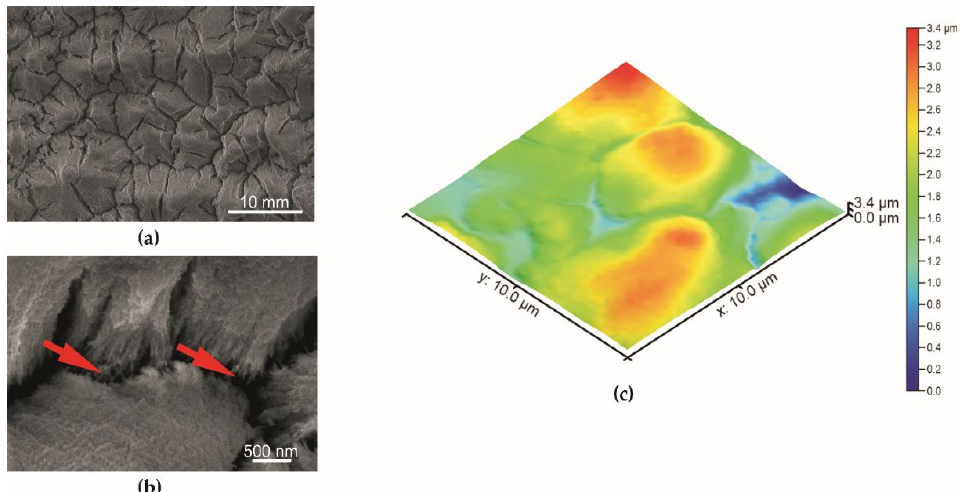
Figure 5. The surface of the specimen from Series 2 before impregnation by PDMS: ( a ) mag. 10,000×; ( b ) mag. 100,000×; ( c ) AFM topography.